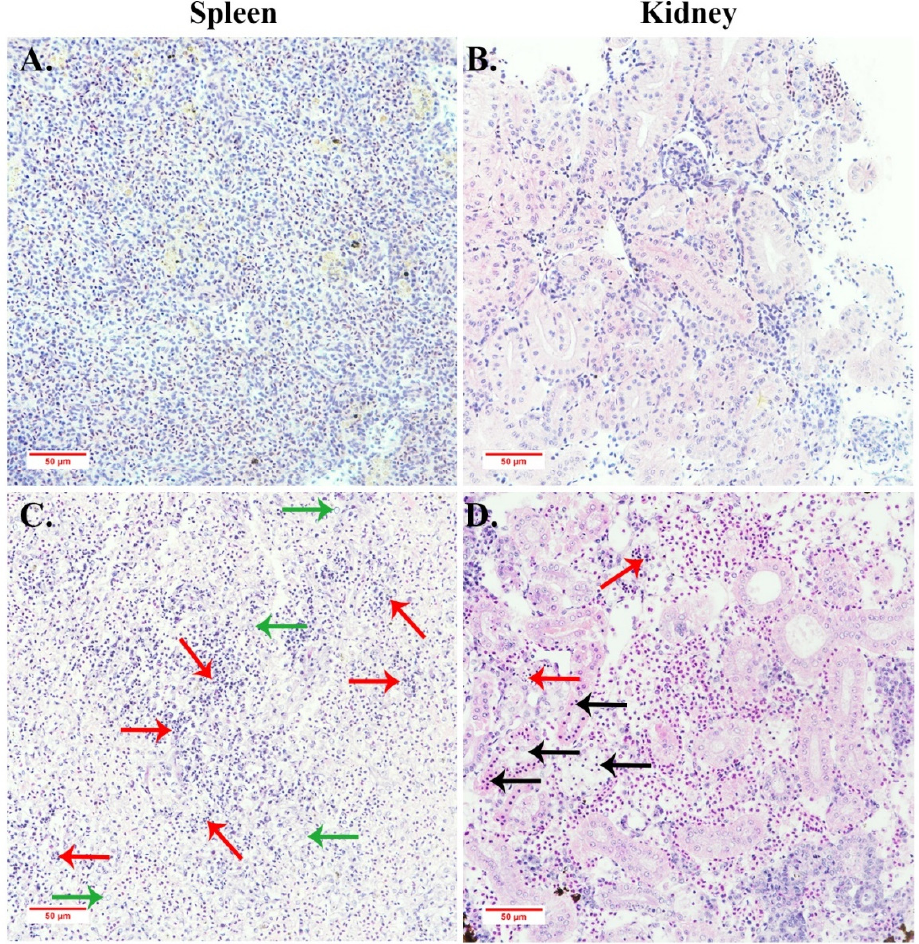
Figure 8. Histopathological observation of the spleen and kidney of ZH-06/20-infected yellowfin seabream. ( A , B ) were the normal spleen and kidney, respectively. ( C ) Infected spleen tissue showed the most severe lesions with abundant vacuolated cells (green arrows) and diffuse karyolysis (red arrows). ( D ) Infected kidney tissue exhibited some karyolysis (red arrows) and distinct pyknosis (black arrows).